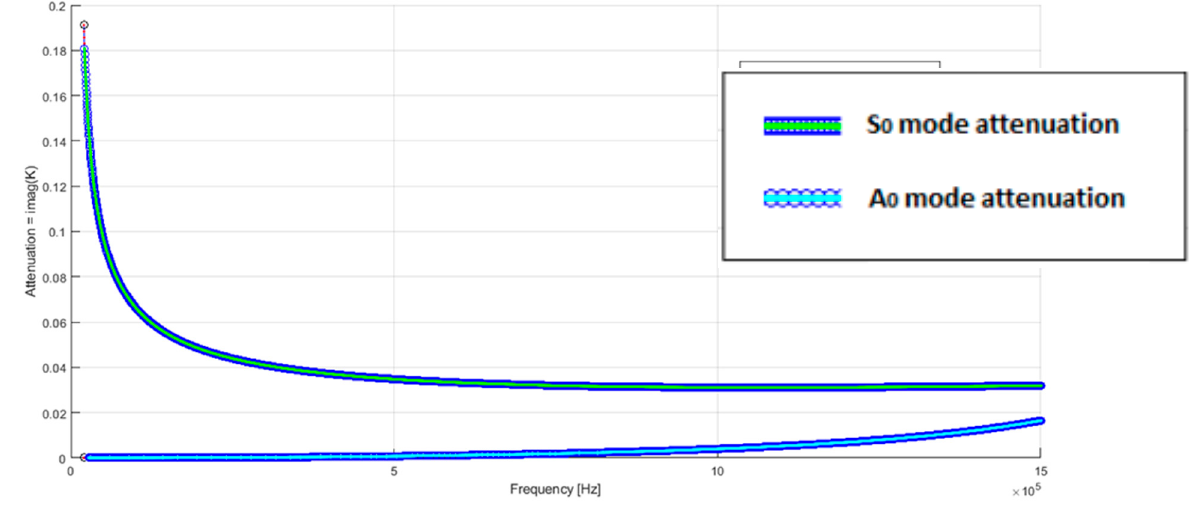
Figure 5. Simulation of the attenuation of the order S 0 and A 0 modes of the Lamb waves for a 1.4 mm thick aluminum laminate.